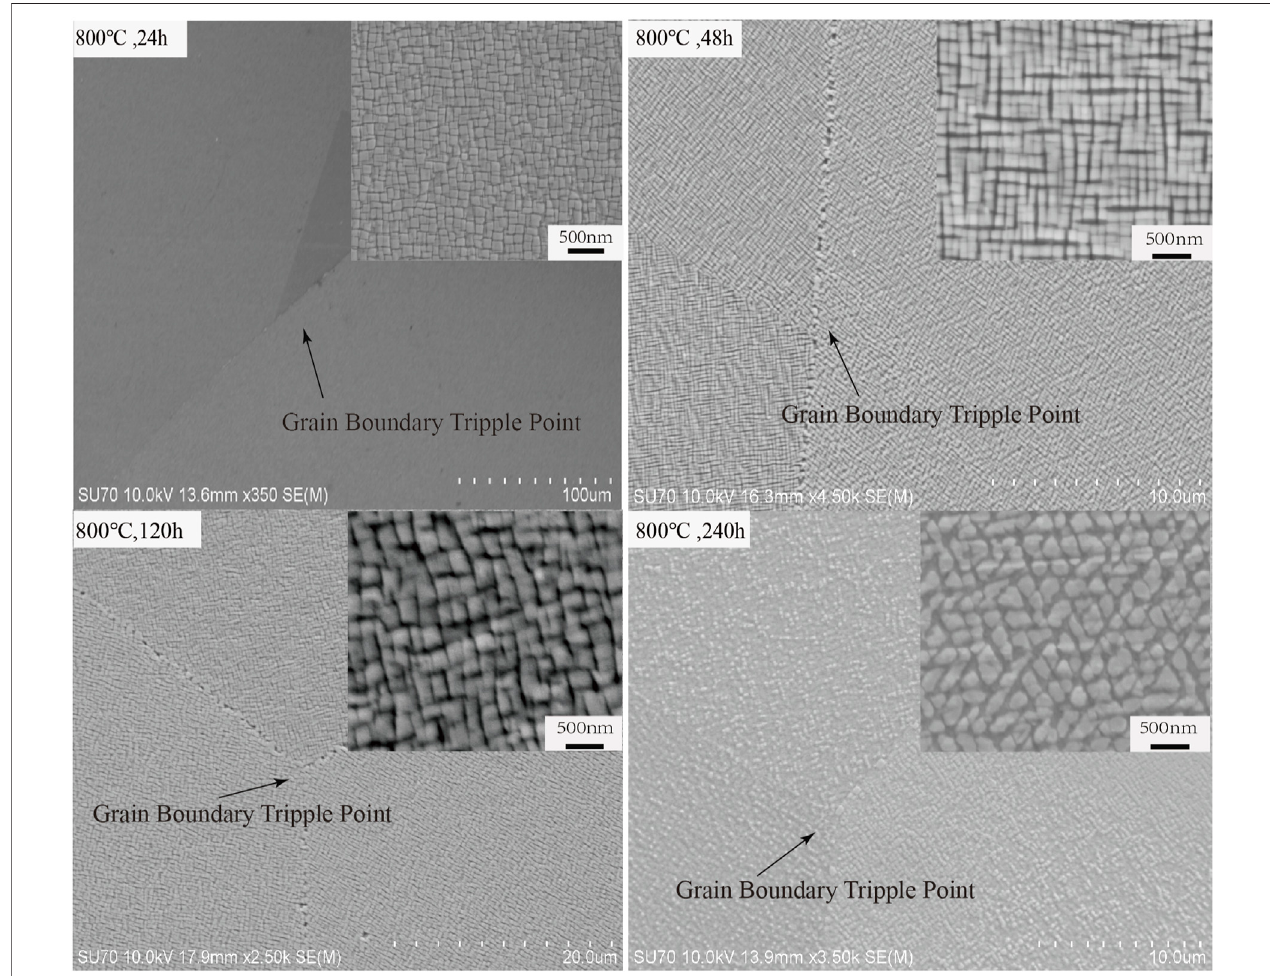
FIGURE 4 | SEM microstructure of Co-30Ni-10Al-6Ta (at %) alloy was annealed at 800 ° C at different times (24 – 240 h).